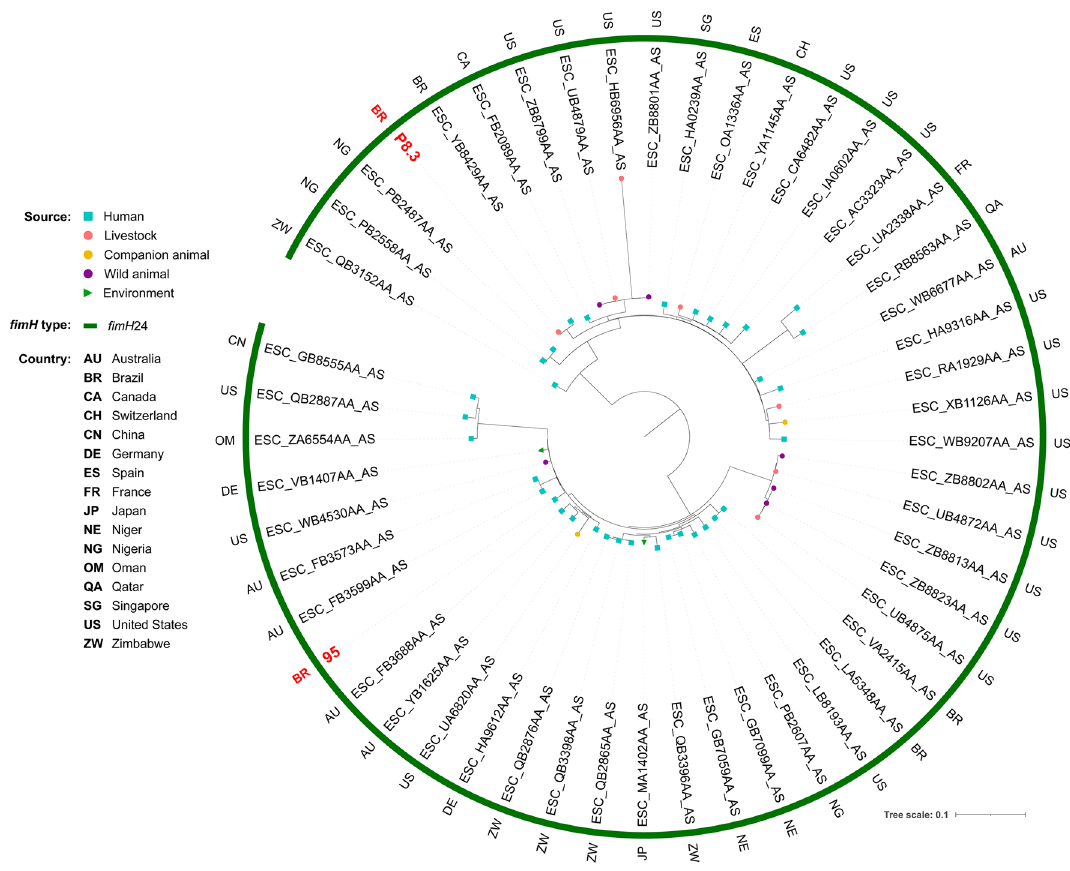
Figure 6. Phylogenetic tree of 51 Escherichia coli ST410 strains, their source, country of collection and fimH